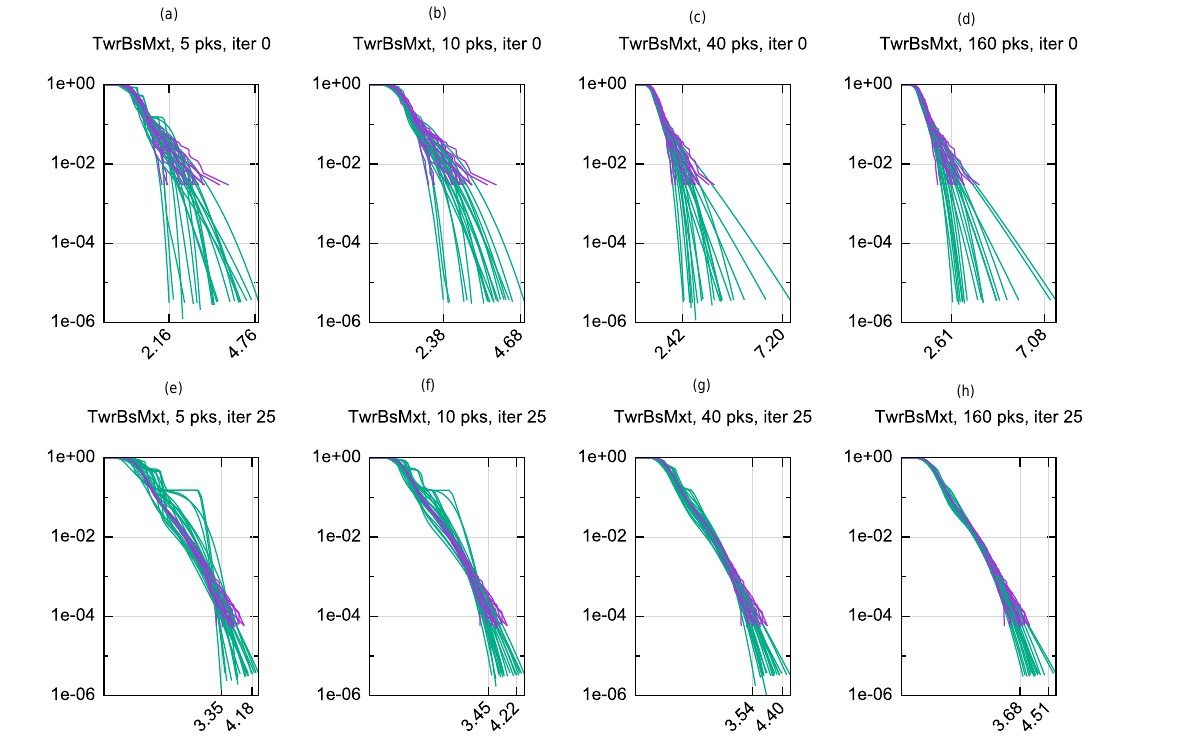
Figure 4. Behavior of ASIS and iterative updating of extrapolation for side–side tower base bending load over 20 separate runs as a function of M pks . The x -axis units are 10000s of kilogram newton meters; the y axis is probability of exceedance in 10min. The top row shows the results of both ASIS and extrapolation at iteration 0 (i.e., just based on the initial set of bin-wise samples) as a function of the number of peaks used for fitting the extrapolation distributions. The bottom row shows the estimates after 25 ASIS iterations. (Note the ASIS results are the same across each row because they are independent of M pks .) Clearly the variance of the estimates is tightened. It is not clear from visual inspection if one choice of M pks is better than any